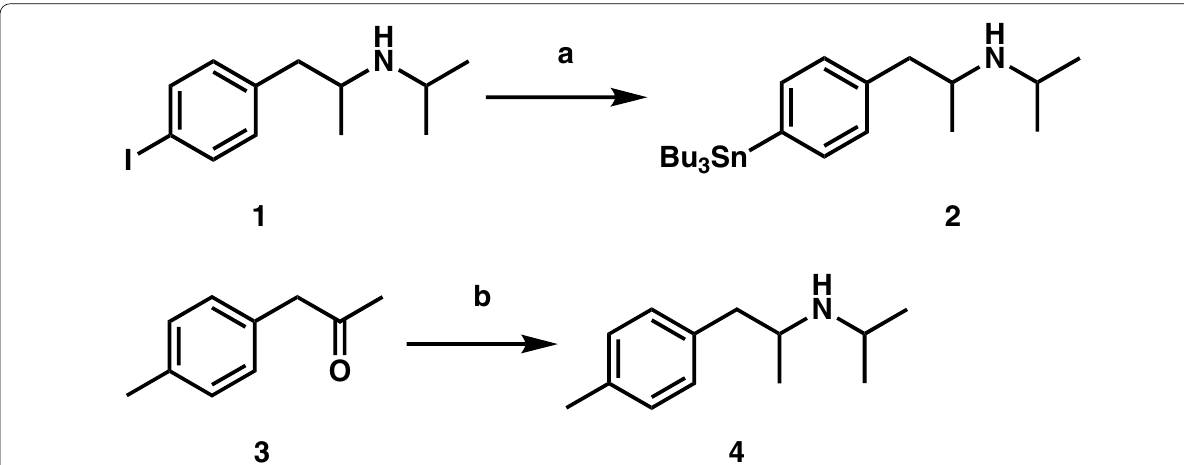
Fig. 1 Synthesis scheme of 1-(4-tributylstannyl)phenyl)- N -isopropylpropane-2-amine ( 2 ) and N -isopropyl- p -methylamphetamine ( 4 ). Reagents